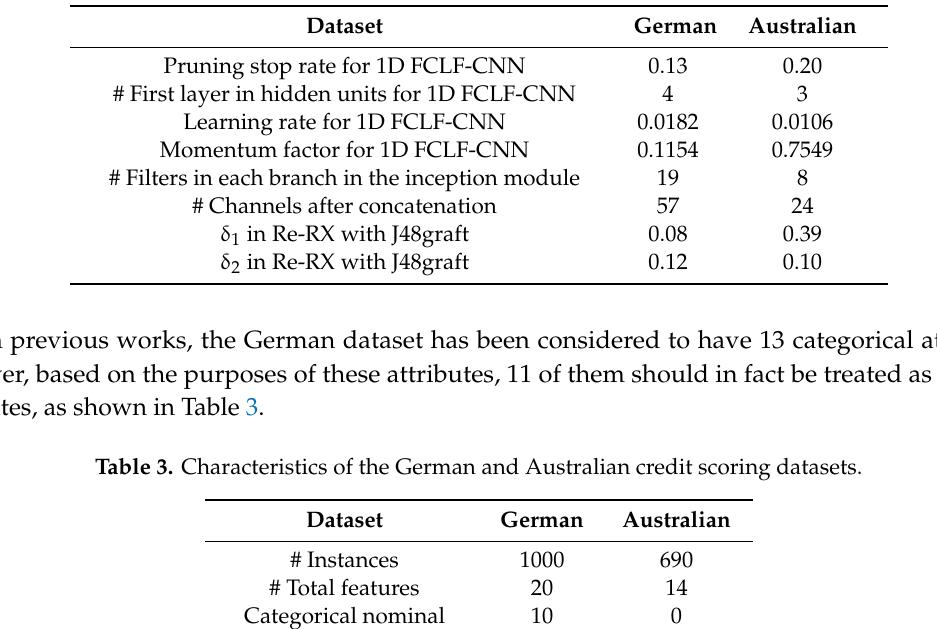
Table 2. Parameter settings for training the 1D FCLF-CNN with Re-RX with J48graft using the German and Australian credit scoring datasets.